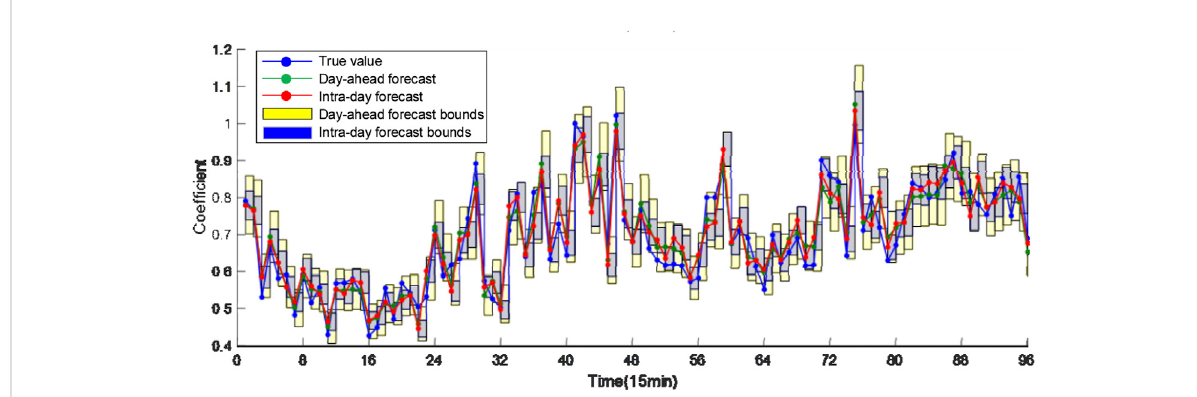
FIGURE 5 Day-ahead and intro-day forecasting curves of normal load.